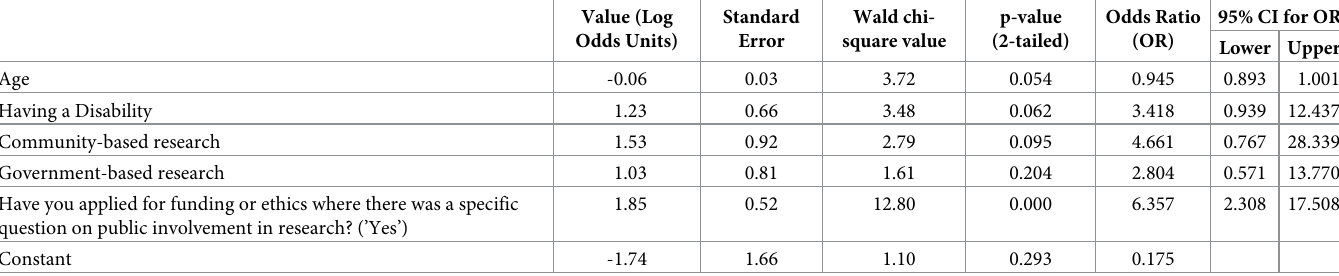
Table 2. Binary logistic regression model for characteristics associated with